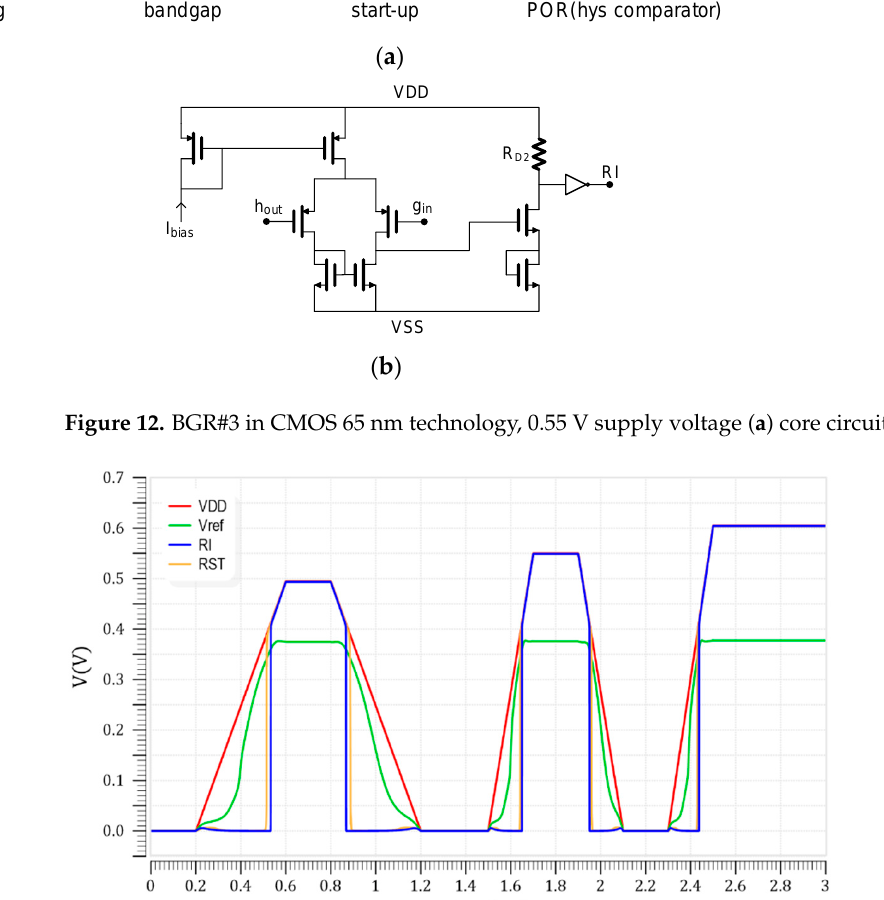
Figure 12. BGR#3 in CMOS 65 nm technology, 0.55 V supply voltage ( a ) core circuit ( b ) RI circuit.